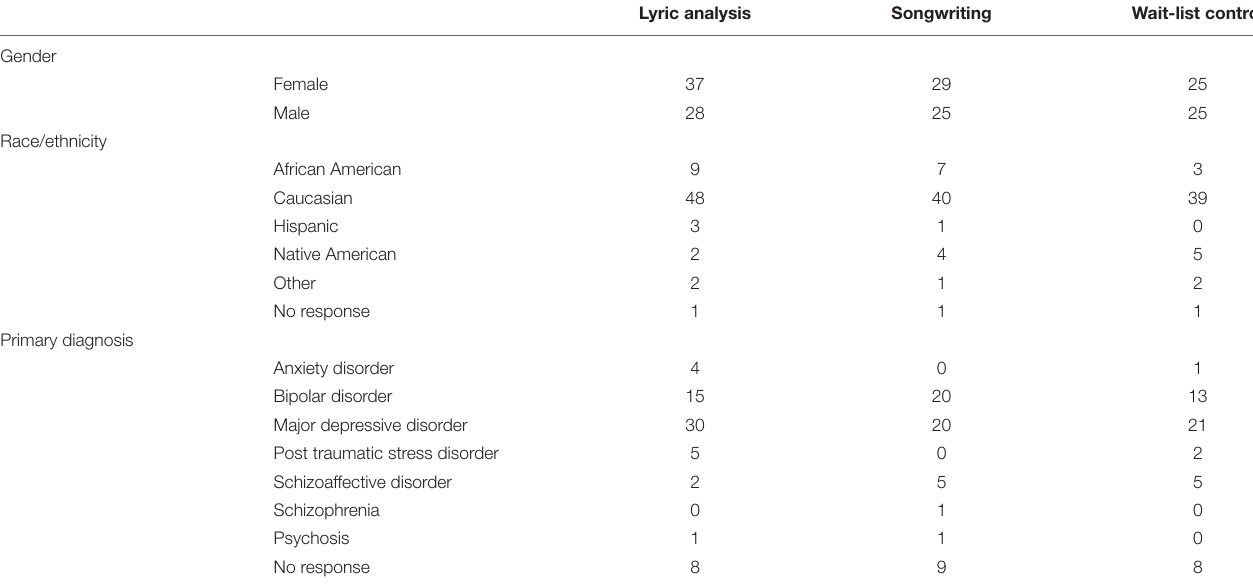
TABLE 1 | Frequencies of gender, race/ethnicity, and primary